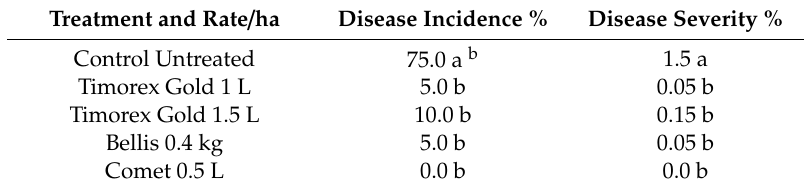
Table 4. Efficacy of formulated TTO in controlling downy mildew in field-grown lettuce plants in Chile a